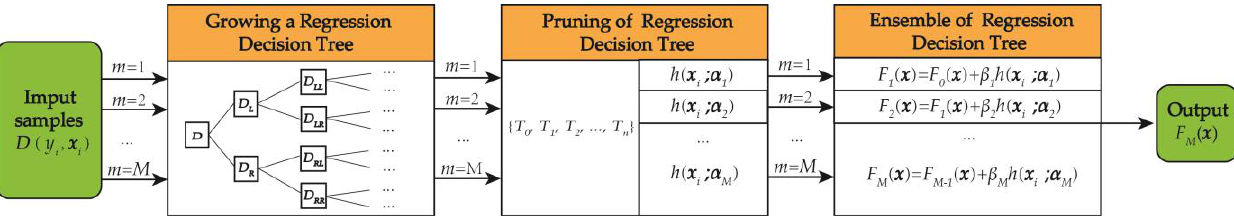
Figure 3. Flowchart of the GBRT algorithm, where D ( y i , x i ) represents the training sample. D L and D R is the left and right subset obtained by optimal splitting of D , respectively. D LL , D LR , D RL , and D RR are the left and right subsets obtained by further optimal splitting of D L and D R . { T 0 , T 1 , T 2 , …, T n } signify the sequence of pruned regression decision trees. h ( x i ; α ) is the subtree with the smallest evaluation criterion selected, and is also the regression decision tree of current training. α m stands for the parameter of the regression decision tree, β m represents the coefficient of the regression decision tree ( m =1, 2, …, M) , M denotes the number of regression trees, and F M ( x ) is the strong learner of the M th iteration.